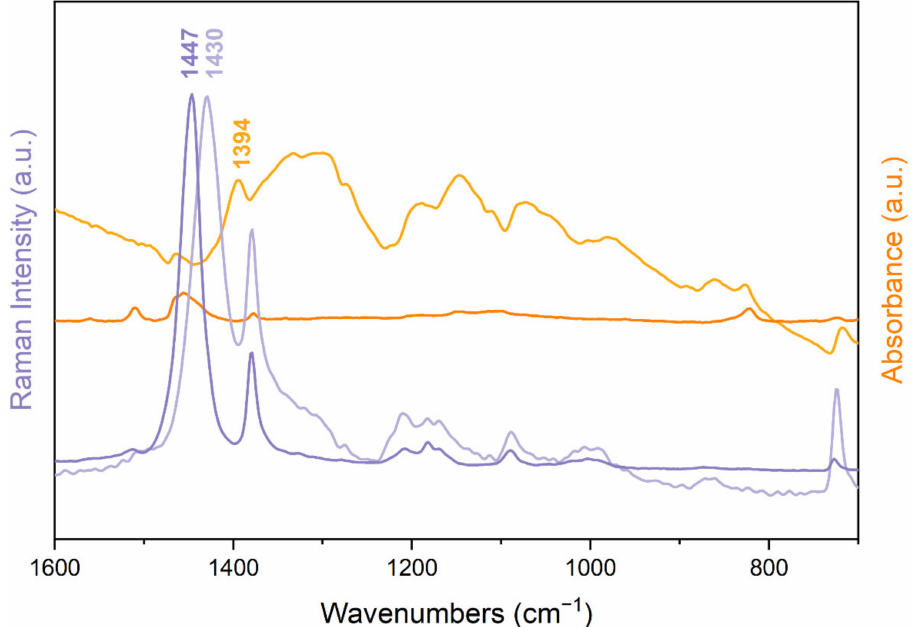
Figure 9. Violet lines are FT-Raman spectra of P3HT nanofibres. Orange lines are IR spectra of P3HT nanofibres. In both cases, the darker line refers to the pristine sample, the lighter line refers to the iodine-doped